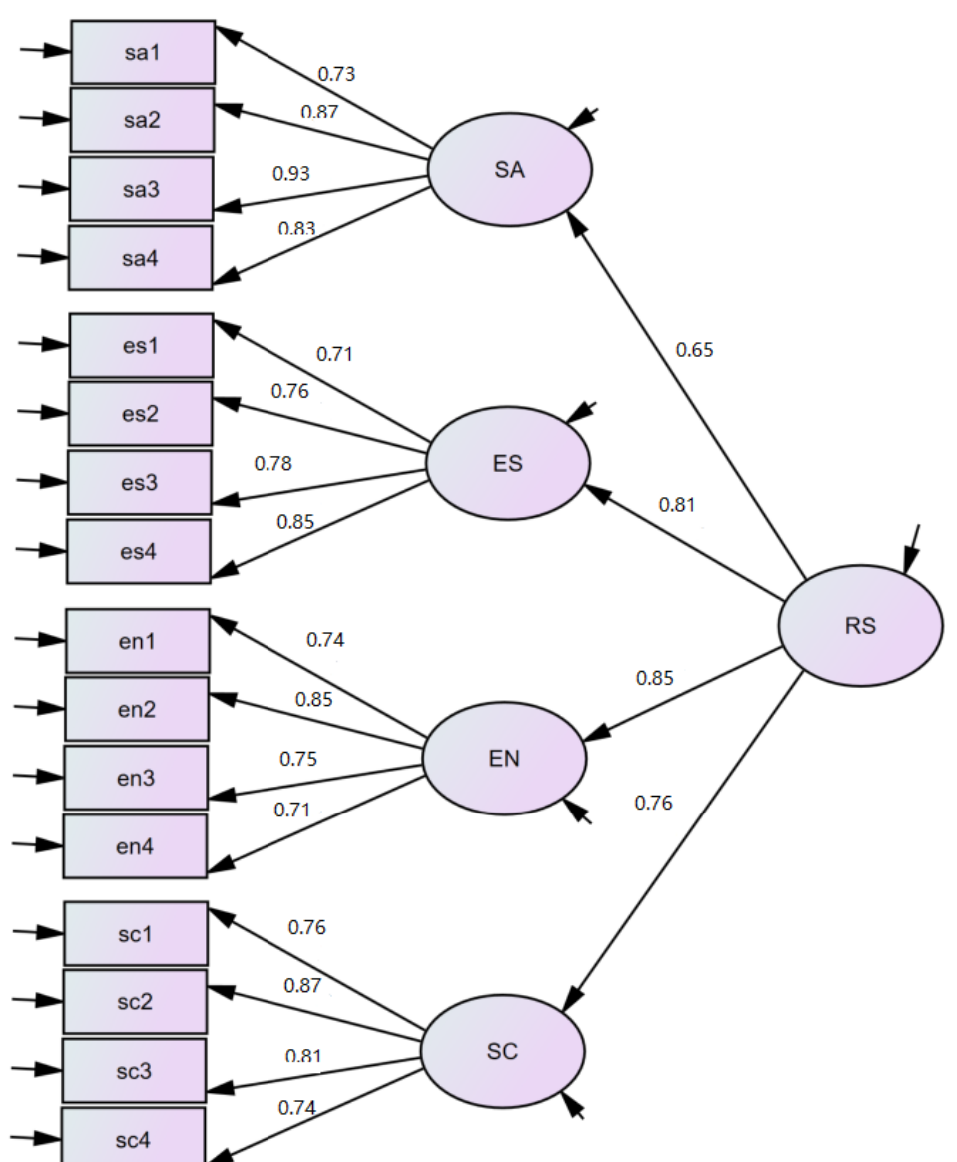
Figure 1. Factor structure model of the Resilience Scale for Chinese Children. (SA: social and agreeable; ES: emotional stability; EN: engagement; SC: self-caring; RS: Resilience